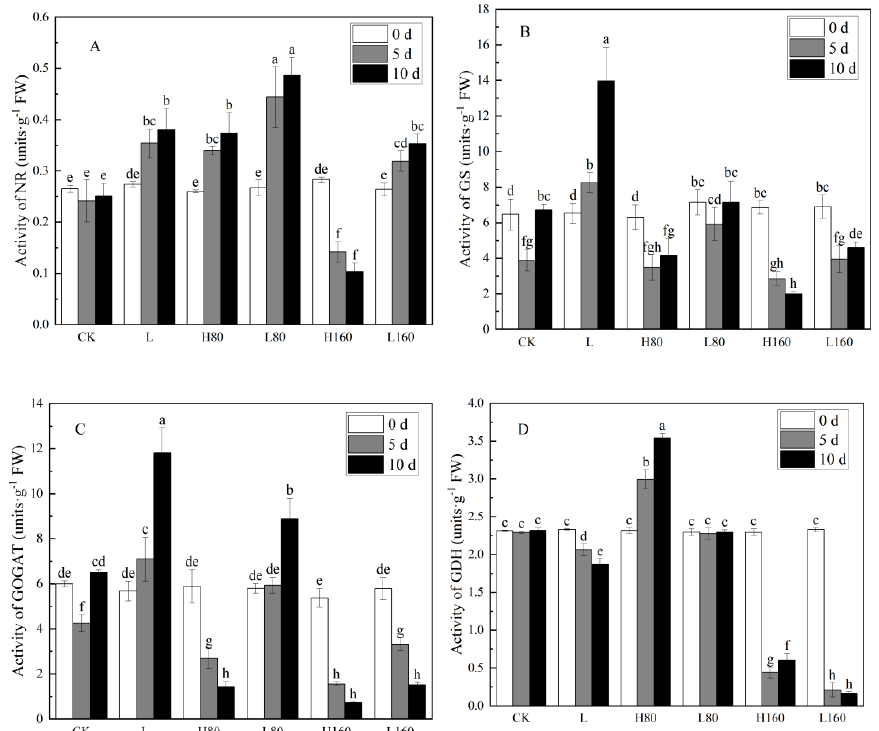
Figure 2. Effects of a low R:FR ratio with excessive nitrate stress on activities of NR, GS, GOGAT and GDH. A: Activity of nitrate reductase (NR), B: Activity of glutamine synthetase (GS) C: Activity of glutamate synthetase (GOGAT) D: Activity of glutamate dehydrogenase (GDH).